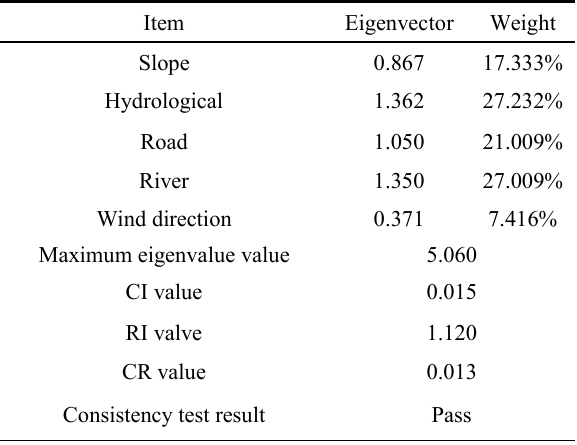
Table 3. AHP hierarchy analysis results.